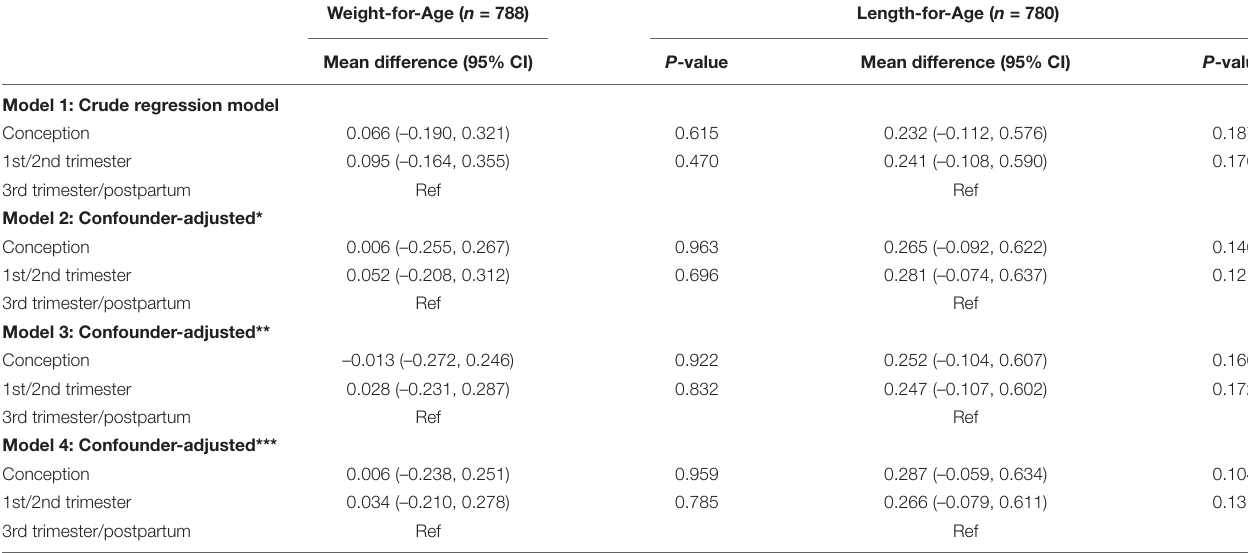
TABLE 2 | Differences in children HIV-exposed and uninfected longitudinal growth by timing of ART exposure by mixed-effects linear regression analysis. Weight-for-Age ( n =